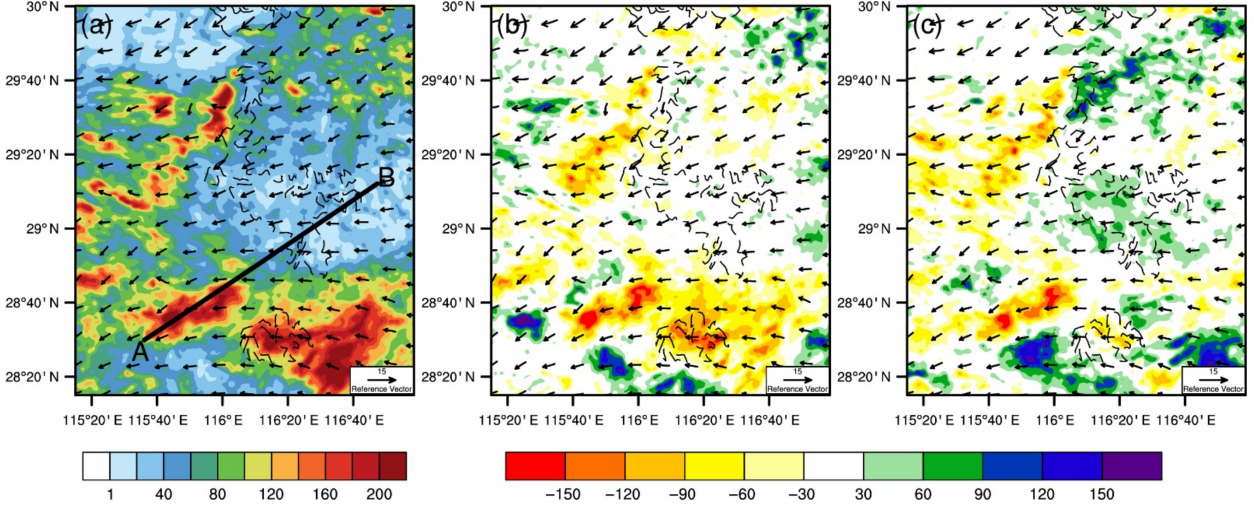
Figure 7. The distribution of the mean total precipitation (mm) and 10 m wind speed (m s − 1 ) from 1 to 12 July. ( a ) Total precipitation in the CTL; ( b ) difference between the CTL and EXPT (EXPT1–CTL) in total precipitation and the 10 m wind speed in EXPT1; ( c ) difference between CTL and EXPT2 (EXPT2–CTL) in total precipitation and the 10 m wind speed in EXPT2. The line AB in ( a ) is the cross section used in Figure